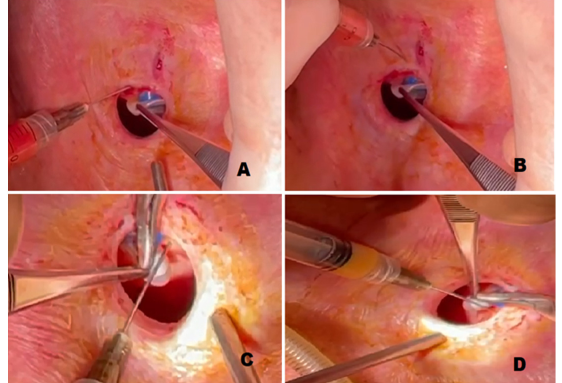
Figure 1. The image illustrates the sites of injection. With the voice prosthesis held in place, the lipoaspirate is injected around the prosthesis ( A ) at 9, ( B ) 12, ( C ) 3, ( D ) and 6 o’clock. The voice prosthesis is held in place during the procedure. Injection is performed until the volume enhancement is considered satisfactory. Patients are usually hospitalized for 1 day after the procedure. Patients are routinely evaluated one and six months after AFG to assess the presence or absence of leakage around the prosthesis. In order to highlight any leakage, they are asked to swallow liquid methylene blue dye. Patients are then observed at a regular annual follow-up. 3. Results Between December 2009 and December 2019, we recorded 661 hospital admissions from 164 patients due to PL. Out of 164 patients, 146 underwent TL with primary closure of the pharynx and 18 were reconstructed with a non-tubed free flap (14 with anterolateral thigh and 4 with forearm). All patients underwent bilateral neck dissection, myotomy of the crico-pharyngeal muscle, and TEP (primary or secondary) for voice restoration. A total of 70.73% of patients (n 116) were subjected to radiotherapy, which was primary (22 pts/13.41%) or adjuvant (94 pts/57.31%). In 60 out of 164 patients (36.58%), a secondary TEP was chosen. The interval between TL and the secondary TEP varied from 2 to 120 months (39.90 ± 12.80). All prostheses were 22.5-French VP (Provox Vega ® , Provox XtraSeal ® , Provox ActiValve ® , Atos Medical AB, Horby, Sweden). Twenty out of the 164 patients (12.19%) experienced large fistula enlargement and were treated with AFG. The characteristics of patients are shown in Table 1. Table 1. Demographic data. Characteristic